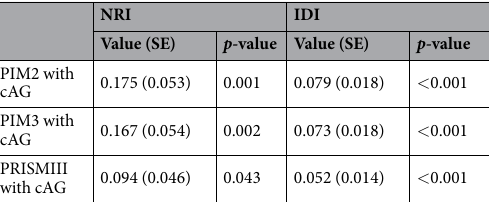
Table 5. NRI and IDI for assessing improvement in mortality prediction after incorporating cAG to pre- existing mortality prediction models in PICU. NRI, Net Reclassification Improvement; IDI, Integrated Discrimination Improvement; cAG, corrected anion gap; PICU, pediatric intensive care unit; SE, standard error; PIM, Pediatric Index of Mortality; PRISM III, Pediatric Risk of Mortality